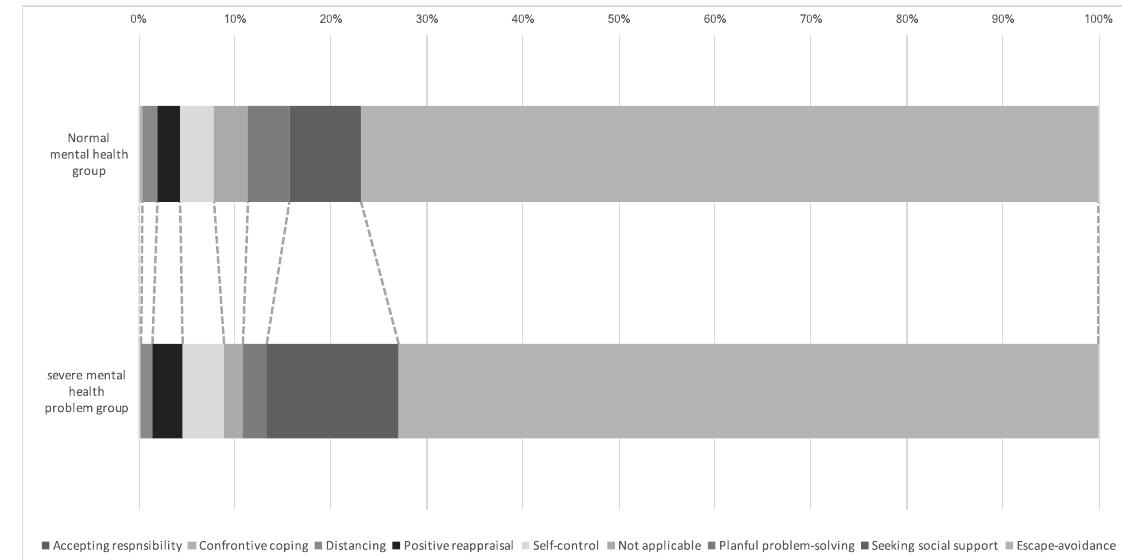
Figure 1. Coping strategies classified using descriptive data according to differences in mental health status.